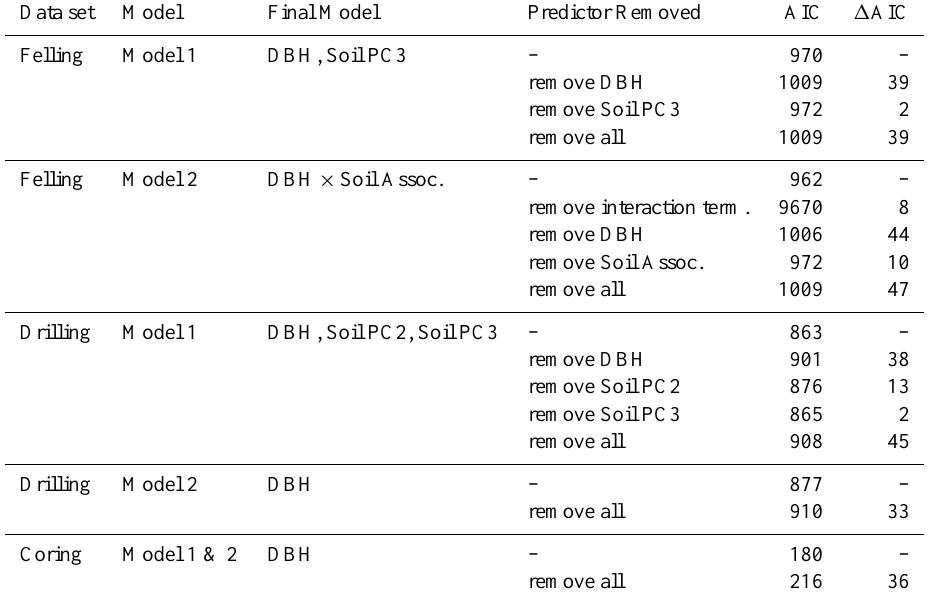
Table 2. Changes in model fit based on Akaike’s Information Criterion (AIC) with removal of single factors from the most-supported generalized linear mixed-model testing associations of the probability of stem rot in trees of mixed dipterocarp rain forest in Sarawak, Borneo, in the drilling, felling, and coring data sets. The (cid:49) AIC shows the increase in AIC when each predictor is removed from the final model. For all models species identity was specified as a random effect. The fixed effects shown are those retained in the best-supported model after model selection based on AIC; see Sect. 2 for details. The following predictor variables were not retained in the final models either as main effects or interactions and so had little effect on variation in stem rot frequency: Felling Model 1 – species wood density and soil PC1, PC2, and PC4; Felling Model 2 – species wood density; Drilling Model 1 – species wood density, soil PC1 and PC4; Drilling Model 2 – species wood density, soil association; Coring Model 1 – tree wood density, soil type; Coring Model 2 – tree wood density, soil association. Abbreviations are as follows: DBH, diameter at breast height; PC, principle component; and Soil Assoc., species soil association. When all predictors are removed, the model is an intercept-only